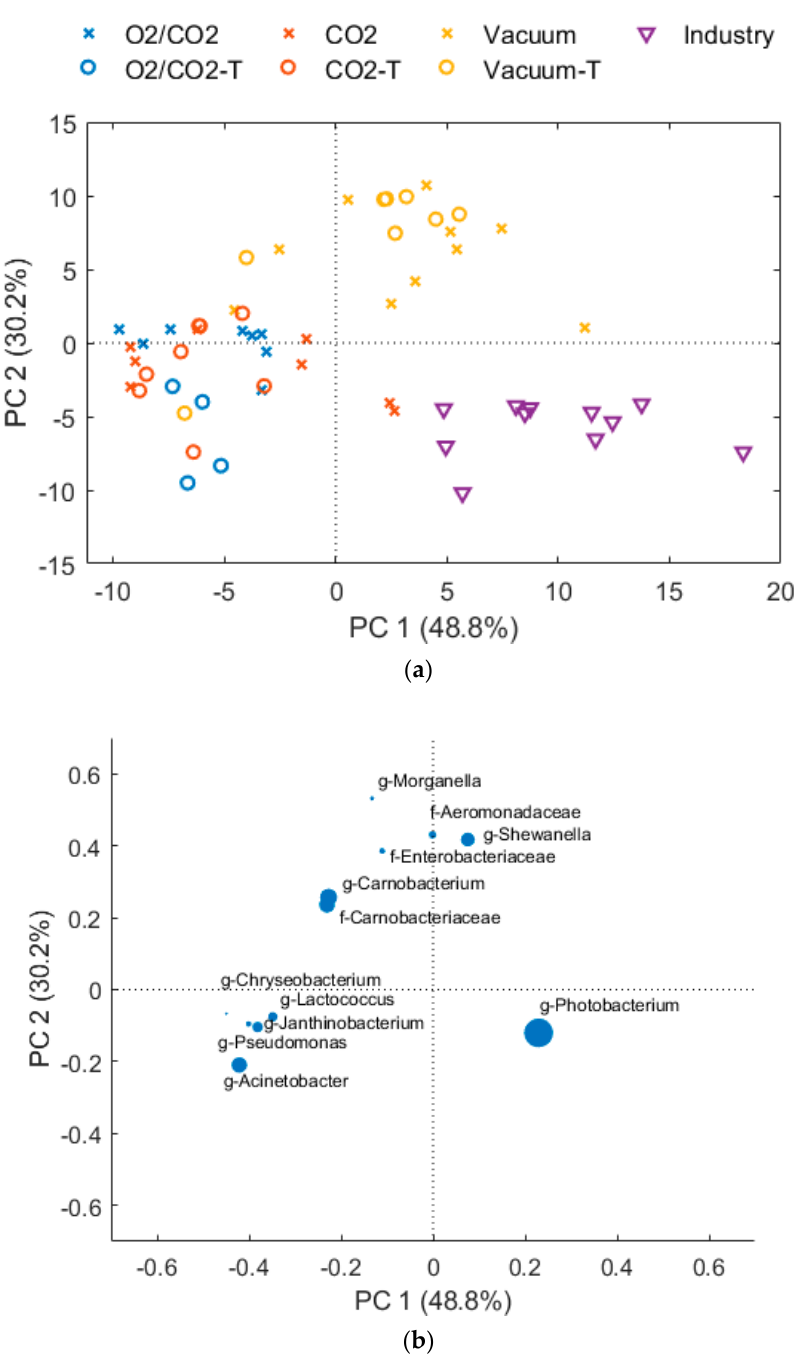
Figure 4. PCA of bacteriota after 1, 5, 8, 13 and 15 days of storage of fresh (cross symbol) and thawed (circle symbol) samples. The “CO 2 ” samples (red color) are packaged with 60% CO 2 , 40% N 2 and a CO 2 emitter, and “O 2 /CO 2 ” (blue color) is packaged with 60% CO 2 and 40% O 2 . “Industry” samples (purple triangle symbol) and “Vacuum” samples (yellow color) are packaged with vacuum. ( a ) Scores plot, days of storage are indicated by label, ( b ) loading plot, dot size corresponds to relative